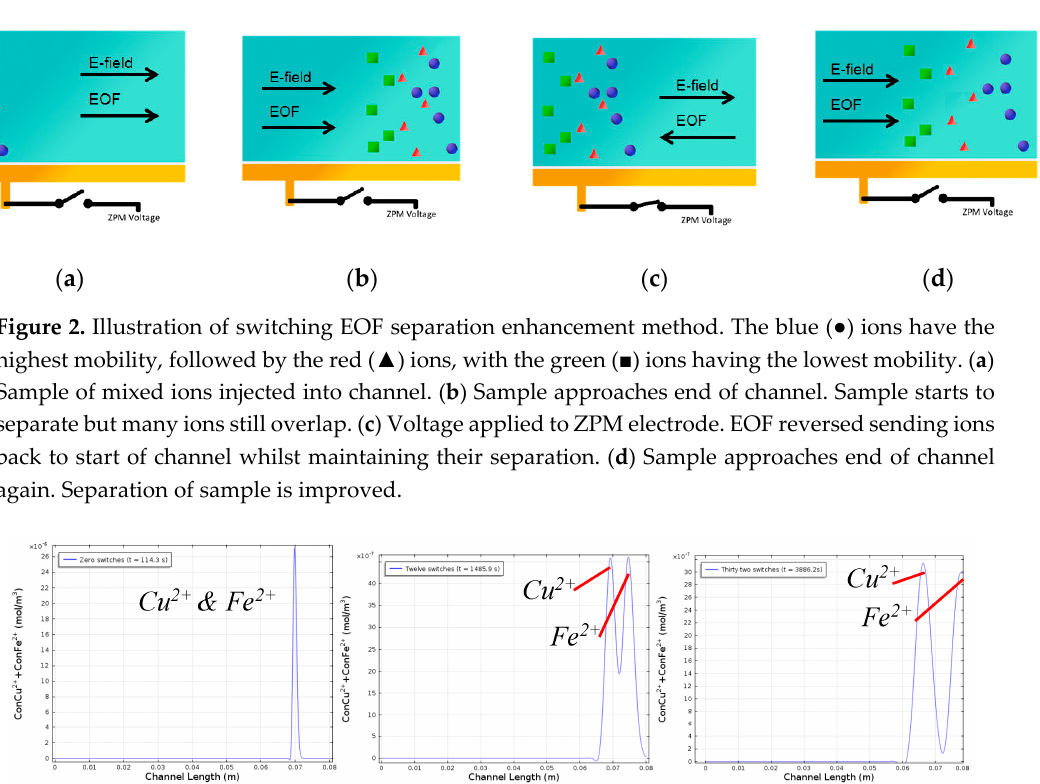
Figure 3. Simulation results showing the effect of the EOF switching to send the sample back and forth along the channel. Number of EOF switches: is shown in the legend of each graph. Sample is depicted at the end of the channel in each